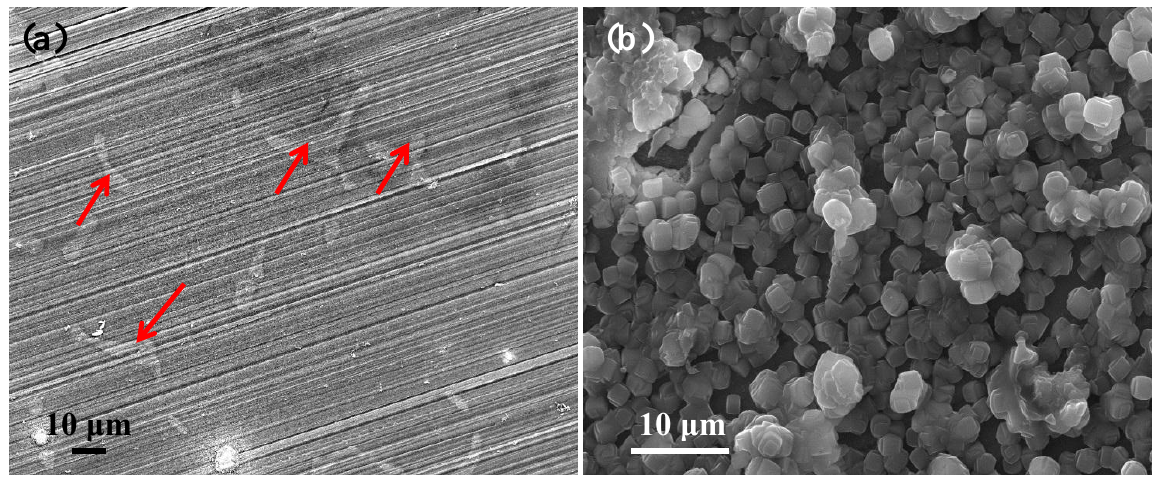
Figure 1. Scanning electron micrograph of ( a ) uncoated and ( b ) zeolite coated AZ91D magnesium